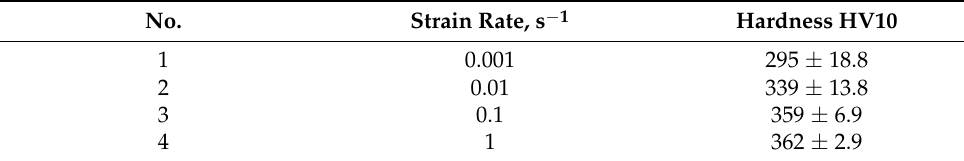
Table 2. Average hardness HV10 of Fe-0.85Mo-0.65Si-1.4C steel after testing.